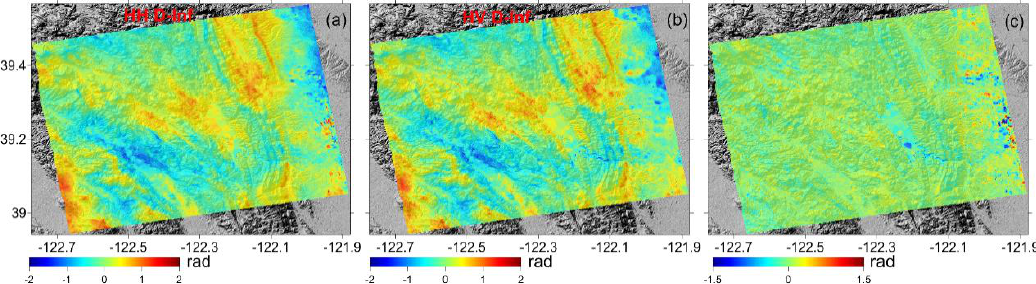
Figure 4. Original ( a ) HH and ( b ) HV D-Infs; ( c ) the difference map between the HV and HH D-Infs.